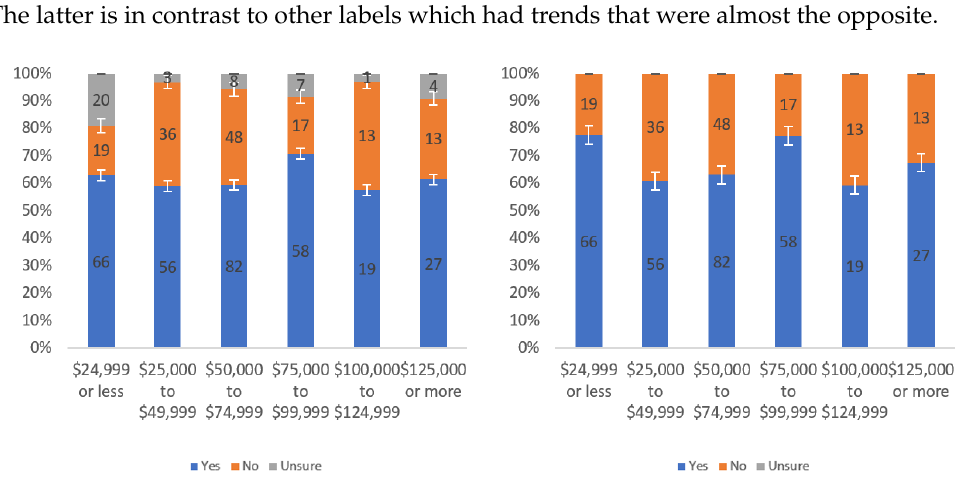
Figure 39. Responses regarding label helpfulness by income level including ( left ) and excluding ( right ) unsure responses.